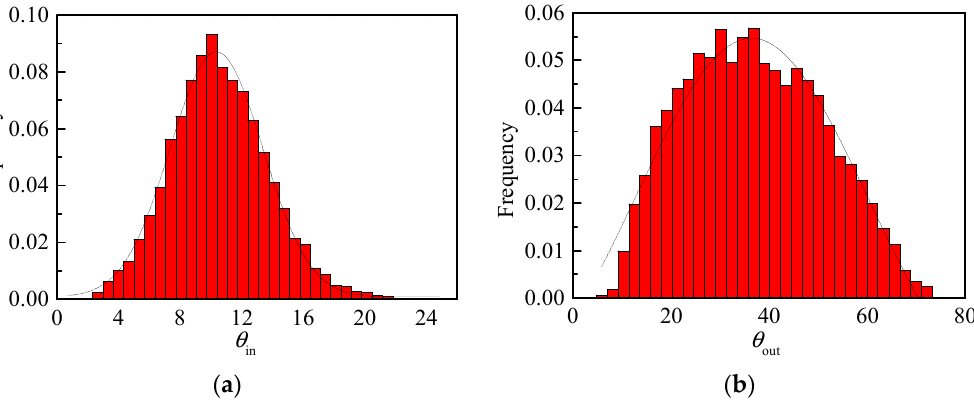
θ and takeoff angle θ . ( a ) Incidence in out